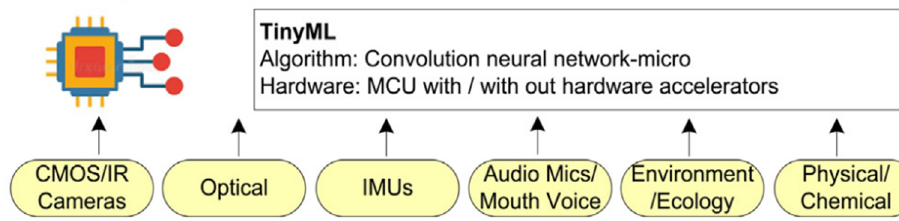
Figure 11. Example of an installed multisensor microcontroller device.